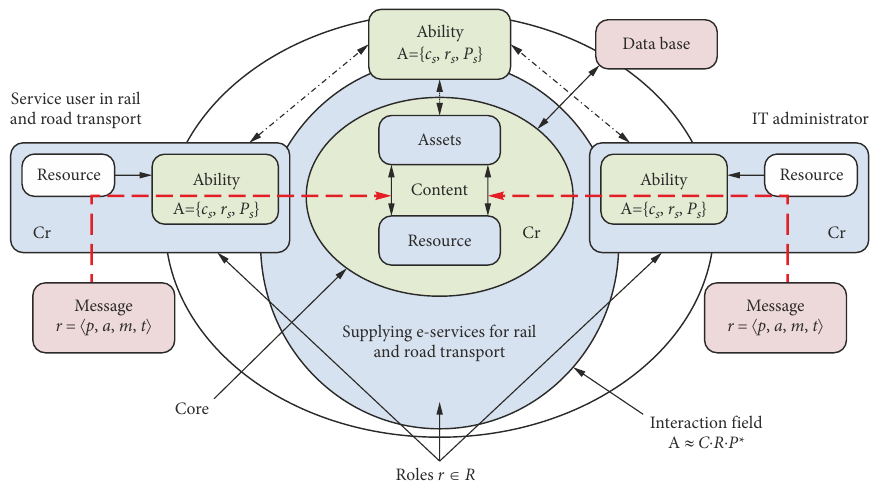
Figure 3. Situational complexity of the factors of the communication dynamics and configuration of the ability status in the ICT transaction model of an urban transport services (adapted according to Banjanin, Gojković (2008); Banjanin (2008a, 2008b); Stjepanovic, Banjanin (2014); Banjanin, Drakulić